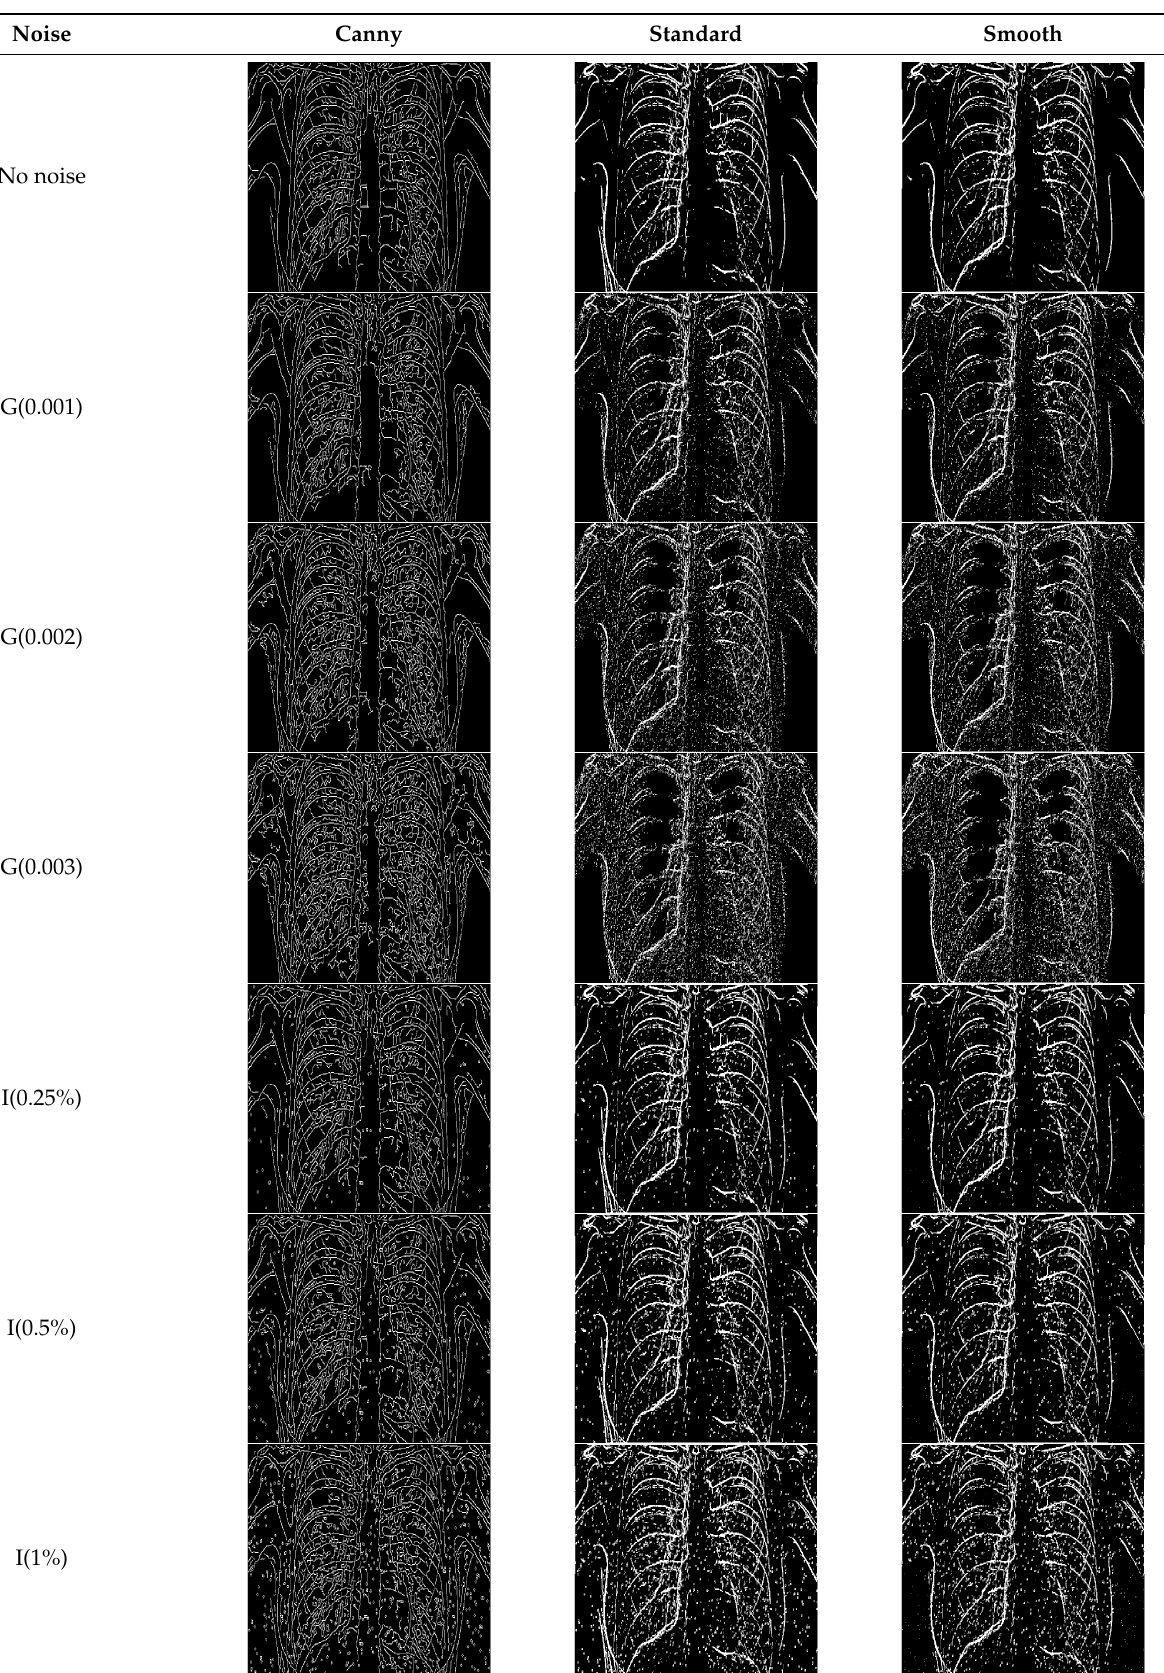
Table 10. Edge-detected image of “X-ray 1” after binarization for different